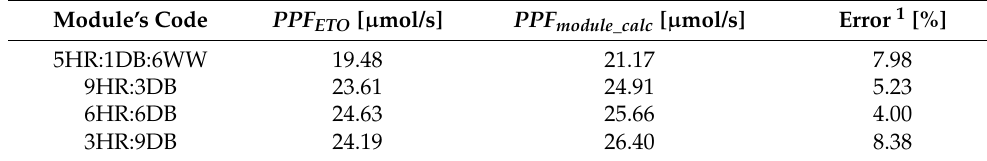
Table 4. Comparison between measured and calculated PPF for each considered LED